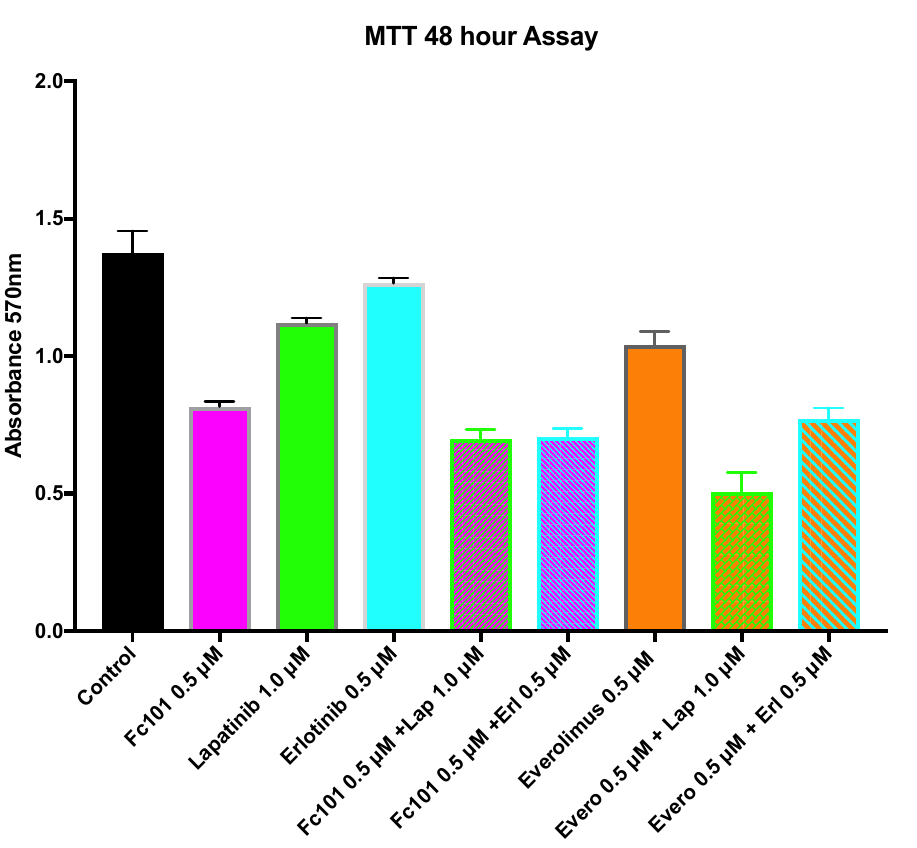
Figure 6. MTT viability assay 48 h post drug treatment. The graph shows the MTT viability assay at the 48 h time point. Treatment concentrations included FC101 (0.5 μM), lapatinib (1.0 μM), erlotinib (0.5 μM), everolimus (0.5 μM), and combinations of FC101 or everolimus with lapatinib or erlotinib.